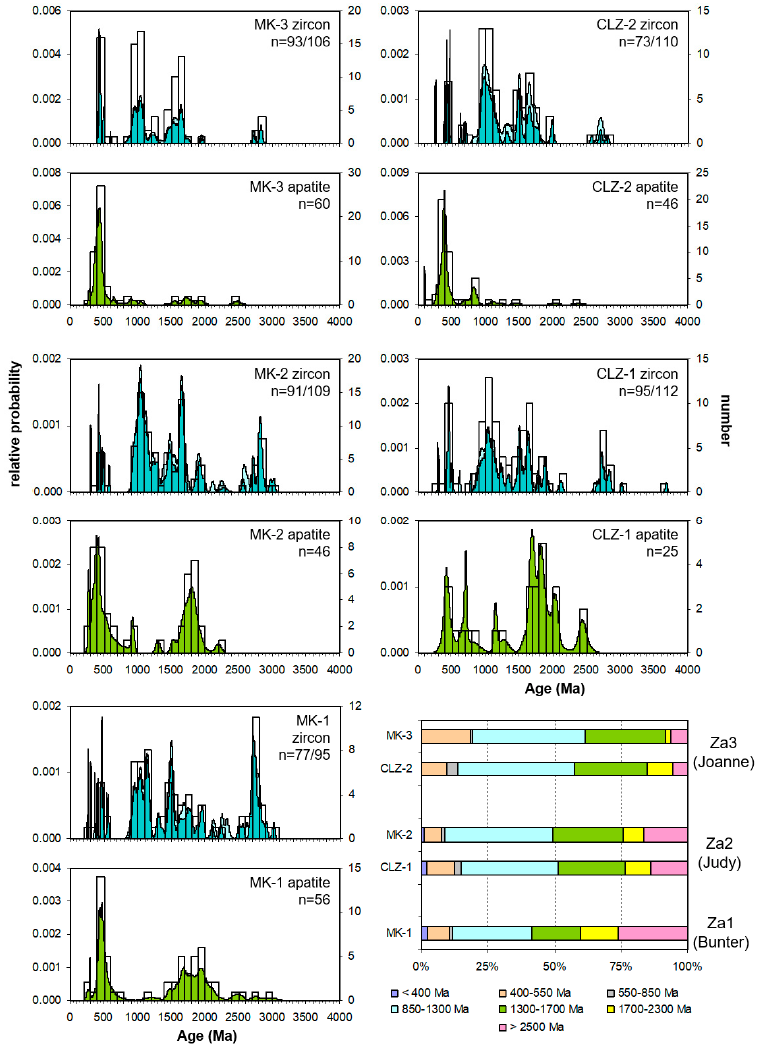
Figure 4. Probability-density plots of zircon and apatite U-Pb ages. For zircon, ‘n’ = number of zircons with <10% discordance in the total zircon population (for example, n = 93/106 indicates 93 concordant ages from a total of 106 analyses). For apatite, ‘n’ = number of analyses. Bar chart in bottom right shows the relative abundance of the main components of the zircon age spectra. See Figure 3 for location of samples MK-1, MK-2, MK-3, CLZ-1 and CLZ-2. Apatite U–Pb age data were also obtained at CAF, using the same equipment as in the zircon U-Pb analysis. The age data were obtained by single spot analyses with a spot diameter of 43 µm and a crater depth of approximately 15–20 µm. The methods employed for analysis and data processing are similar to those described in detail by Gerdes and Zeh [69] and Frei and Gerdes [70]. The Madagascar apatite [79,80] was used as primary cali- bration material. For quality control, the Durango apatite [81] was analysed, and the